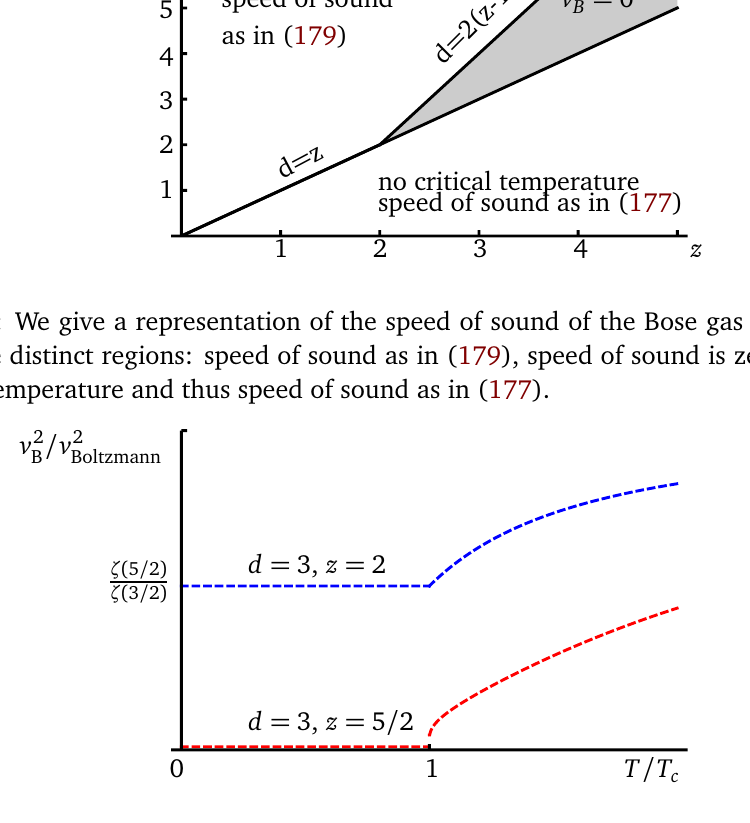
Figure 2: We present two different situations for the speed of sound of the Bose gas. The upper line ( d = 3 and z = 2) corresponds to a finite speed of sound in the condensate phase (for T > 0), whereas the lower line ( d = 3 and z = 5 / 2) corresponds to a speed of sound that is equal to zero anywhere in the condensate